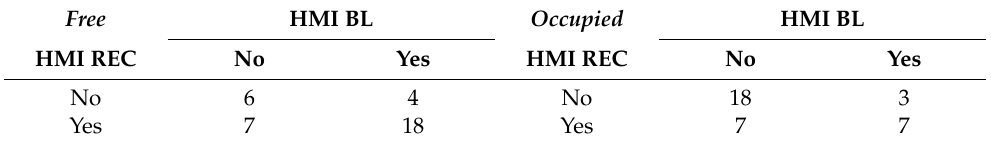
Table 2. Contingency tables on the decision to intervene during the free and occupied scenario.